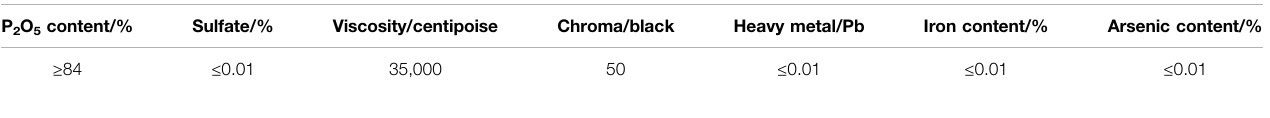
TABLE 3 | Physical indices of